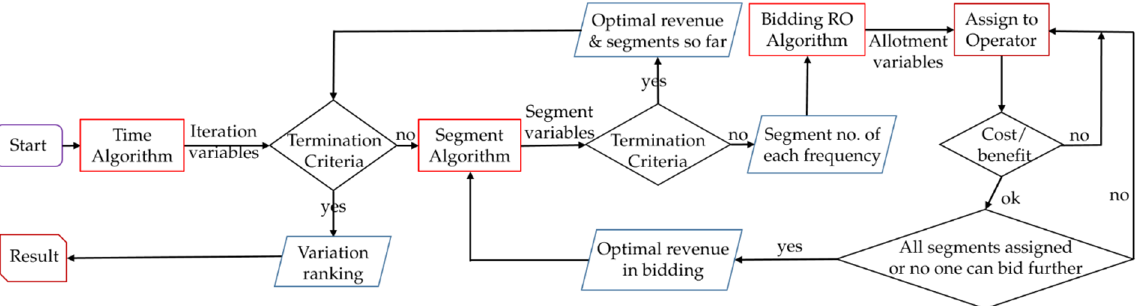
Figure 1. Flow of three layers optimization.